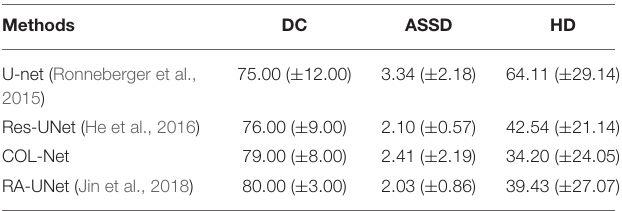
TABLE 4 | Ablation study about performance of 4 networks with DC, ASSD and HD